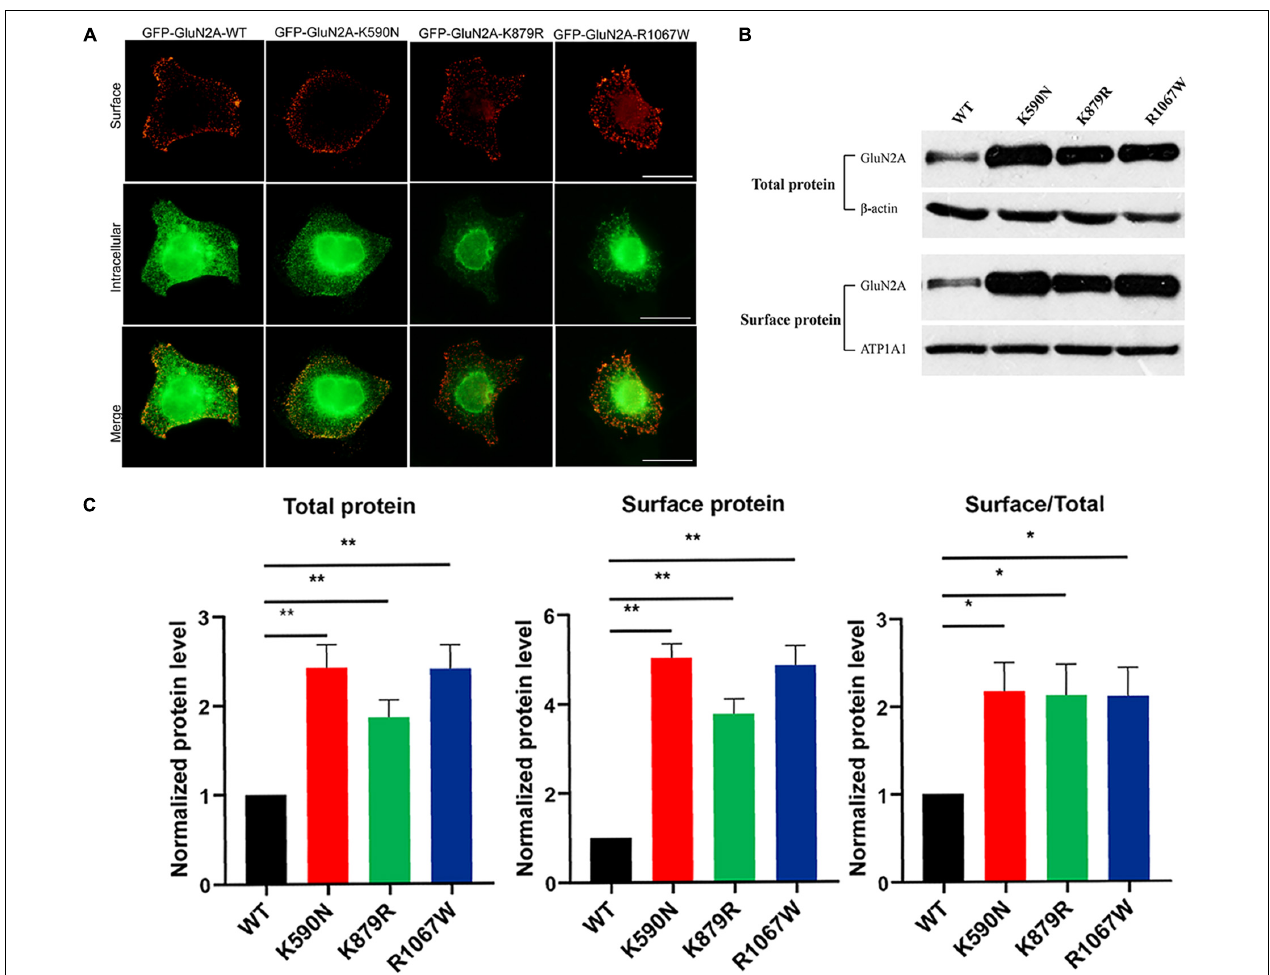
FIGURE 5 | Surface and total expression of GluN2A-WT and GluN2A-mutant NMDARs detected by immunofluorescence staining and biotinylation. (A) Surface (red, upper row) and intracellular (green, lower row) expression of GluN1/GluN2A-WT or mutant NMDARs in HEK 293 cells. (B) Western blot detected the total and surface protein expression of GluN2A-WT, GluN2A-K590N, GluN2A-K879R, and GluN2A-R1067W NMDARs. (C) Quantitative analysis of the total and surface expression of GluN2A-WT and GluN2A-mutants NMDARs and their corresponding ratio of the surface/total expression as shown in panel (B) ( n = 5. One-way ANOVA with Bonferroni post hoc multiple comparison test, * P < 0.05; ** P < 0.01). NMDAR, N -methyl- D -aspartate